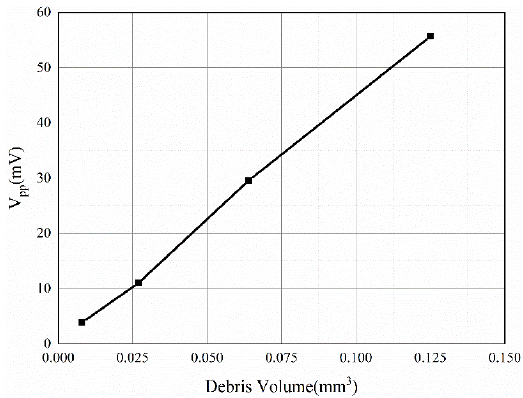
Figure 9. Influence of wear debris volume.